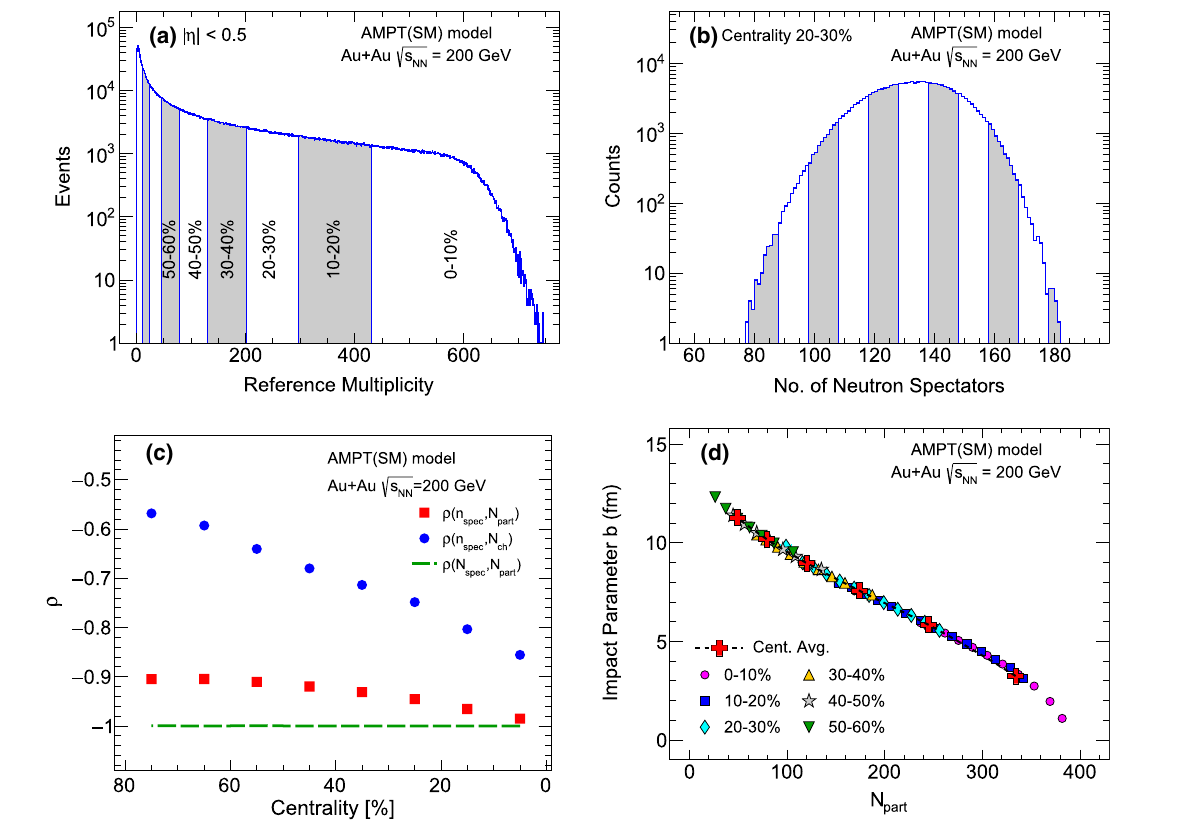
Fig. 1 a The multiplicity in | η | < 0 . 5 ( N ch ) for minimum-bias Au+Au √ s NN = 200 GeV. In alternating white and gray bands, dif- collisions at ferent centrality bins from 0–10% to 70–80% are shown. b The total spectator neutron number ( n spec ) distribution for 20–30% centrality. The different L+R bins are shown in alternating white and gray bands.